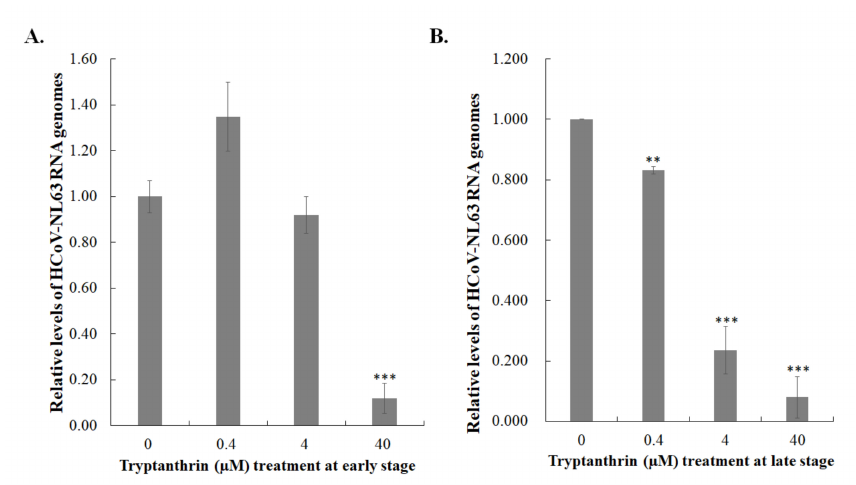
Figure 8. Inhibitory e ff ect of tryptanthrin on the synthesis of viral RNA genome in the early and late stages of HCoV-NL63 replication. The cell monolayer was infected with HCoV-NL63 and treated with tryptanthrin simultaneously ( A , early stage), or 1 hpi ( B , late stage). After 2 h of incubation, the virus / tryptanthrin mixture was removed; the cell monolayer was washed with PBS and cultured for an additional 24 h with incubation at 37 ◦ C. Total RNA from treated and transfected cells was extracted and reverse transcribed with HCoV-NL63-specific primers. Relative viral RNA genomes were measured by quantitative PCR and normalized by β -actin mRNA. **, p value < 0.01; ***, p value < 0.001 compared with mock-treated infected cells.